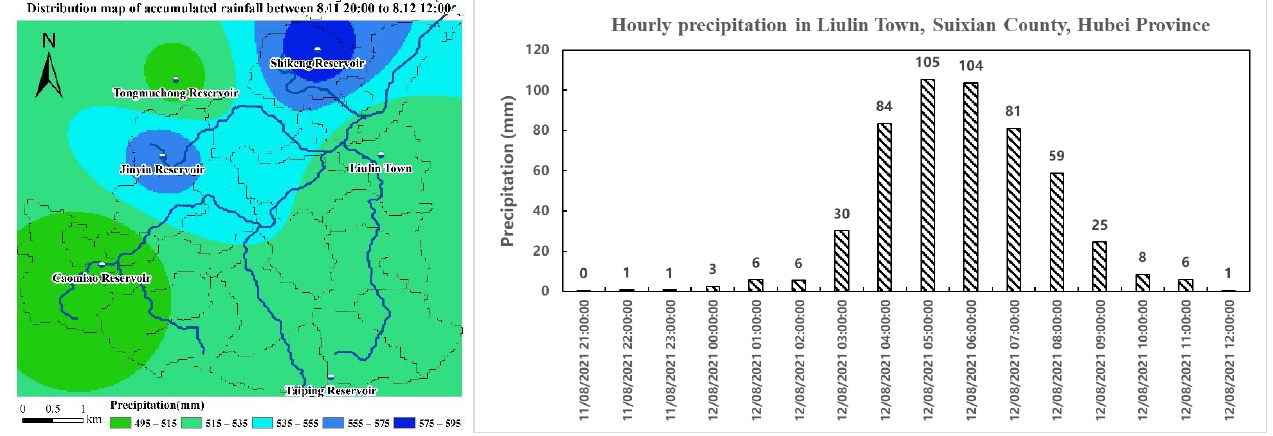
Figure 2. Spatial distribution map of accumulated rainfall and hourly rainfall in Liulin Town, Hubei Province.